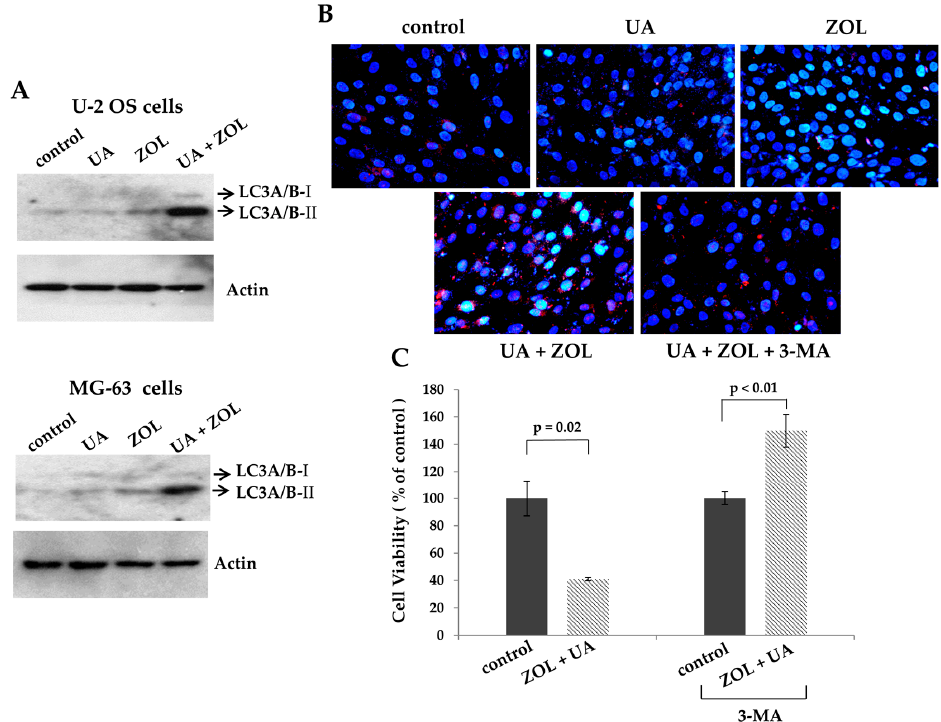
Figure 5. Autophagy is involved in the anti-proliferative activity of zoledronic acid/ursolic acid combination. ( A ) zoledronic acid combines with ursolic acid to induce the expression of LC3A/B-II. U-2 OS cells or MG-63 cells were treated with either ZOL (10 μ M), UA (20 μ M) or a combination of ZOL and UA for 48 h. Cells were harvested and the cell lysates were analyzed by Western blotting using indicated antibodies; ( B ) zoledronic acid combines with ursolic acid to induce acidic autophagic vacuoles. MG-63 cells were treated with either ZOL (10 μ M), UA (20 μ M) or a combination of ZOL and UA in the absence or present of 3-MA (2 μ M) for 36 h. The cells were stained with acridine orange (AO) to observe acidic (autophagic) vacuoles ( red color), and 4',6-diamidino-2-phenylindole (DAPI) for labeling nucleus ( blue color); and ( C ) autophagy inhibitor blocks the anti-proliferative effect caused by the UA/ZOL combination. U-2 OS cells were treated with ZOL (10 μ M) and UA (20 μ M) in the absence or presence of 3-MA (2 μ M) for 48 h. The treated cells were processed to MTT assays to measure cell viability. Cell viability of drug-treated cells was compared to their own control cells in the absence